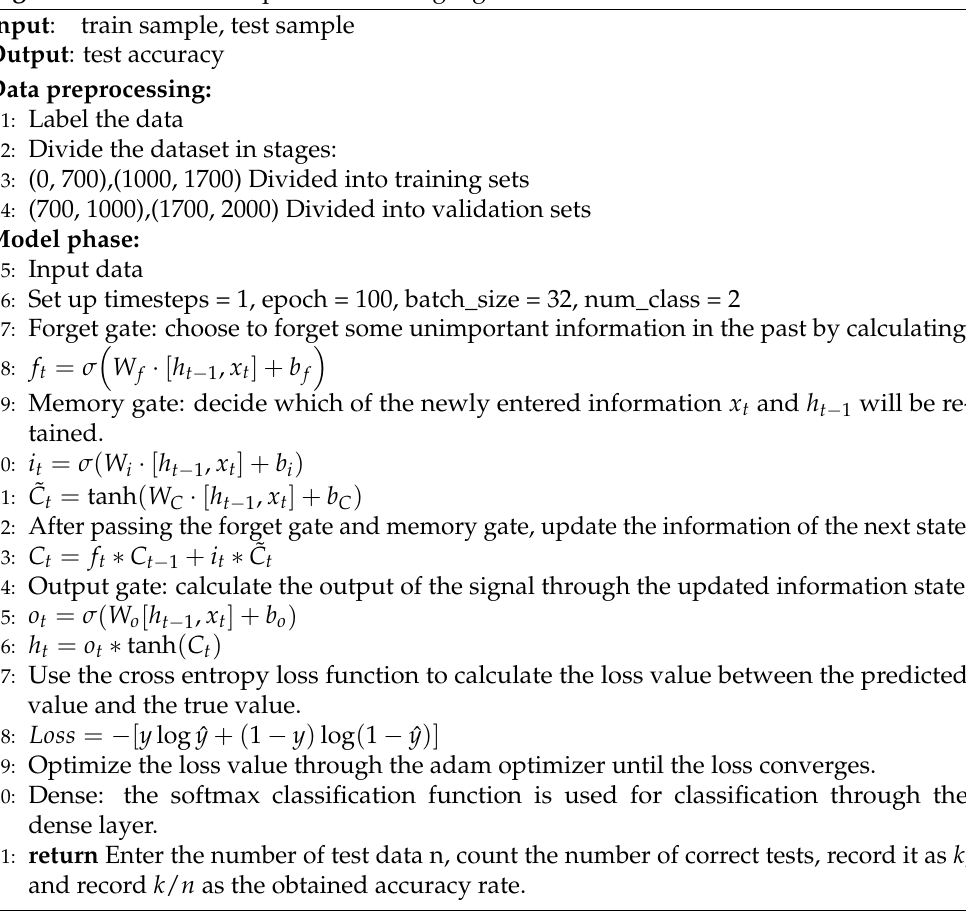
Algorithm 1 CM-LSTM spectrum-sensing